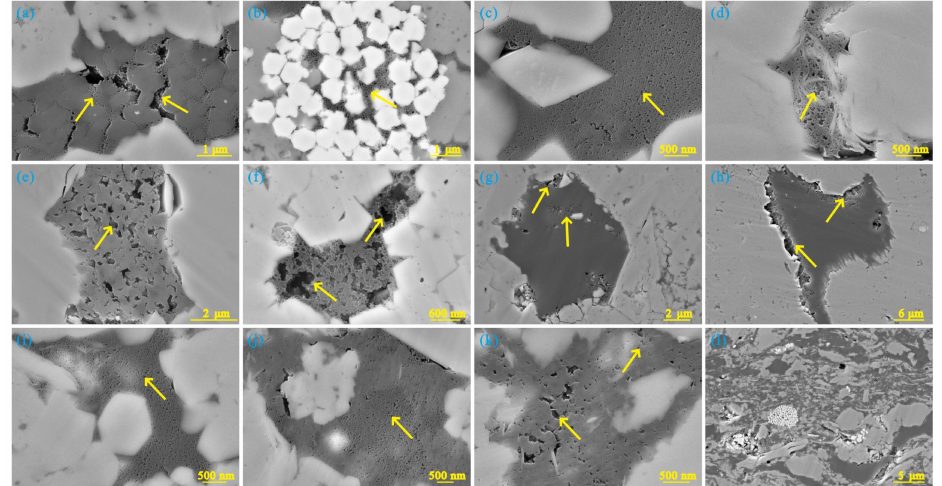
Figure 8. Organic matter distributions, pore morphologies, and pore development characteristics of Dalong Formation shales with ( a – d ) Moderate TOC and quartz contents, ( e – h ) Low TOC and high quartz contents, ( i – l ) High TOC and low quartz contents. ( a ) Isolated and interconnected organic pores (yellow arrow) developed within organic matter (1229.6 m depth in well ED-2). ( b ) Organic pores (yellow arrow) developed from solid bitumen filling the intercrystalline pores of a pyrite framboid (1229.6 m depth). ( c ) Organic pores (yellow arrow) developed from solid bitumen filling interparticle pores (1234.2 m depth). ( d ) Organic pores (yellow arrow) developed from organic matter and clay mineral assemblages (1234.2 m depth). ( e ) Elliptical to worm-like organic pores (yellow arrow) (1237.2 m depth). ( f ) Collapsed and interconnected organic pores (yellow arrow) (1237.2 m depth). ( g ) Organic pores (yellow arrow) are not developed within organic matter but at its edge (1252.9 m depth). ( h ) Organic matter (yellow arrow) without internal pores but with contracted slit pores at its edge (1252.9 m depth). ( i , j ) Small organic pores (yellow arrow) are evenly distributed throughout organic matter (1244.2 m depth). ( k ) Organic pores of heterogeneous sizes (yellow arrow) are unevenly distributed throughout organic matter (1249.2 m depth). ( l ) Oriented organic matter and mineral particles, showing fluid shapes (1249.2 m